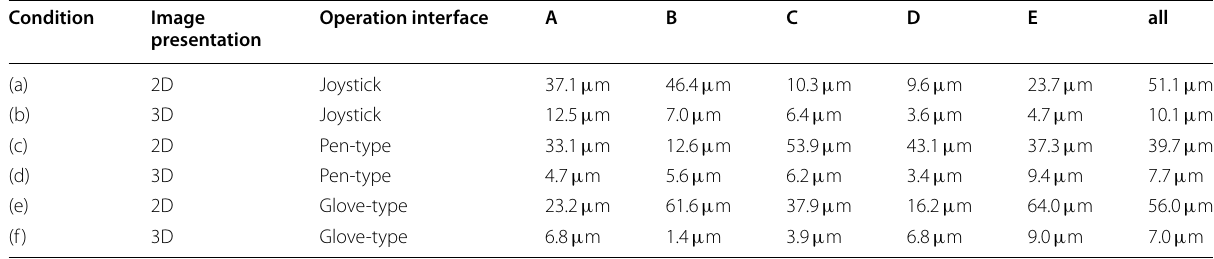
Table 5 Standard deviation of error Condition Image